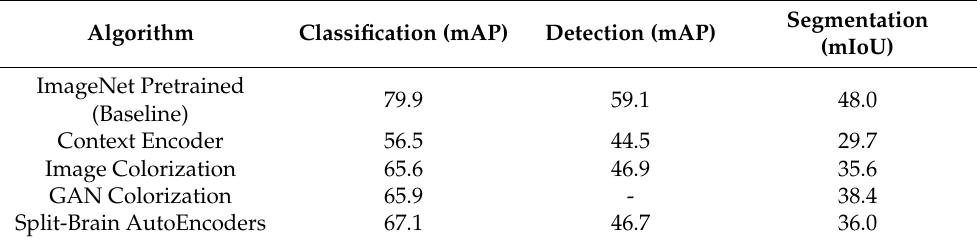
Table 2. Results of transferring learned feature representations from Pixel-to-Pixel pretext tasks for the downstream tasks of classification and detection on the PASCAL VOC 2007 dataset and segmentation on the PASCAL VOC 2012 dataset using a standard AlexNet